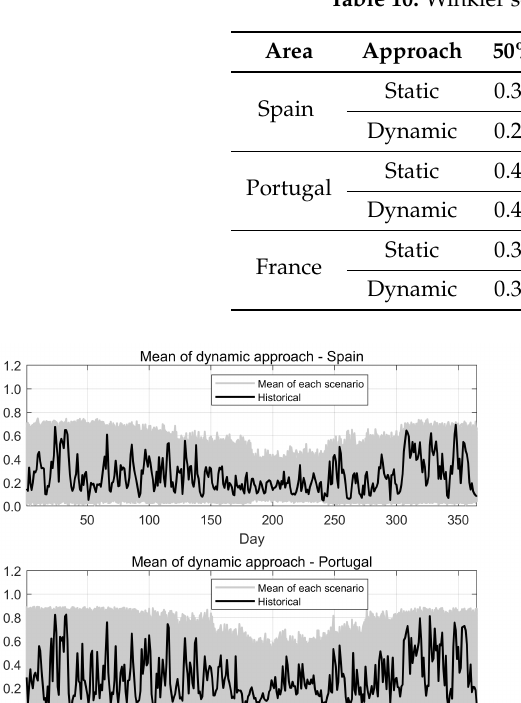
Table 10. Winkler score for daily approach.